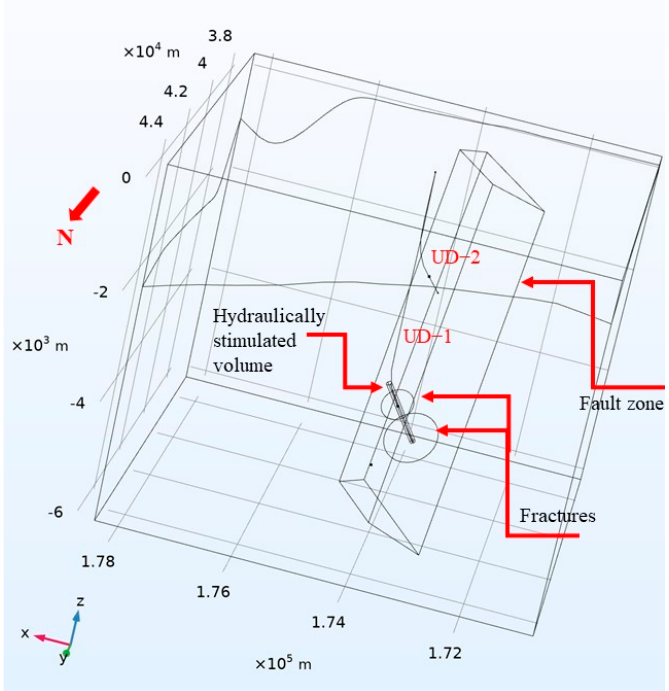
Figure 4. Schematic geometry used to simulate a cubic space of the UDDGP geothermal system. The hydraulically stimulated region is depicted by a cylinder around UD − 1. Two critically stressed large-scale fractures, subparallel to the PTF, are implemented based on the seismic events as documented by, e.g., [11] and indicated with a disc shape.